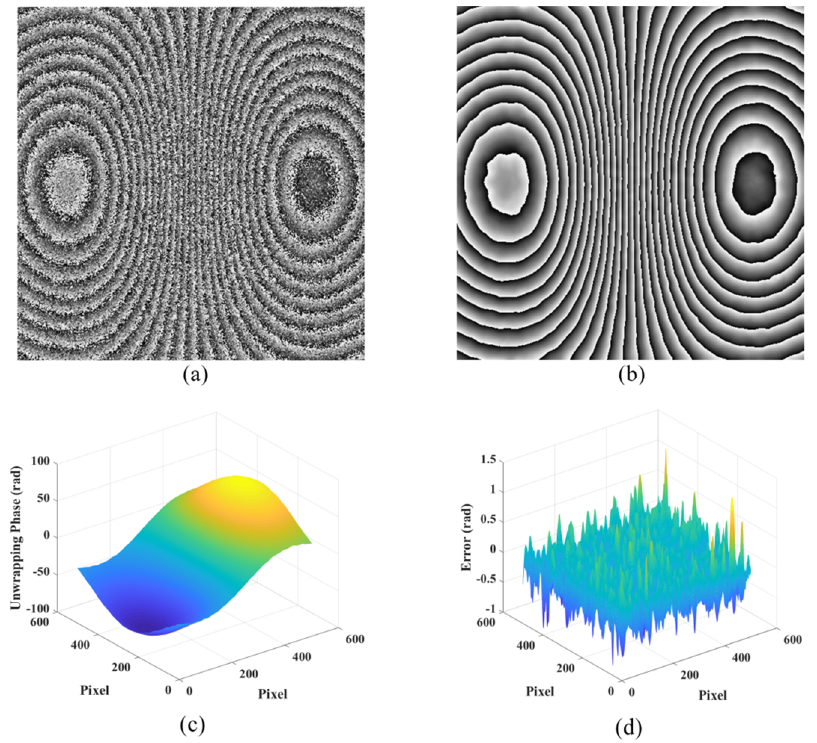
Figure 6. Simulated data (the speckle radius of 2 pixels): ( a ) Simulated noisy wrapped phase; ( b ) denoising result of (a) by the proposed method; ( c ) unwrapped phase of (b); ( d ) error distribution of (c). Table 1. Performance of the proposed method. Figure Noisy Data (MSE)